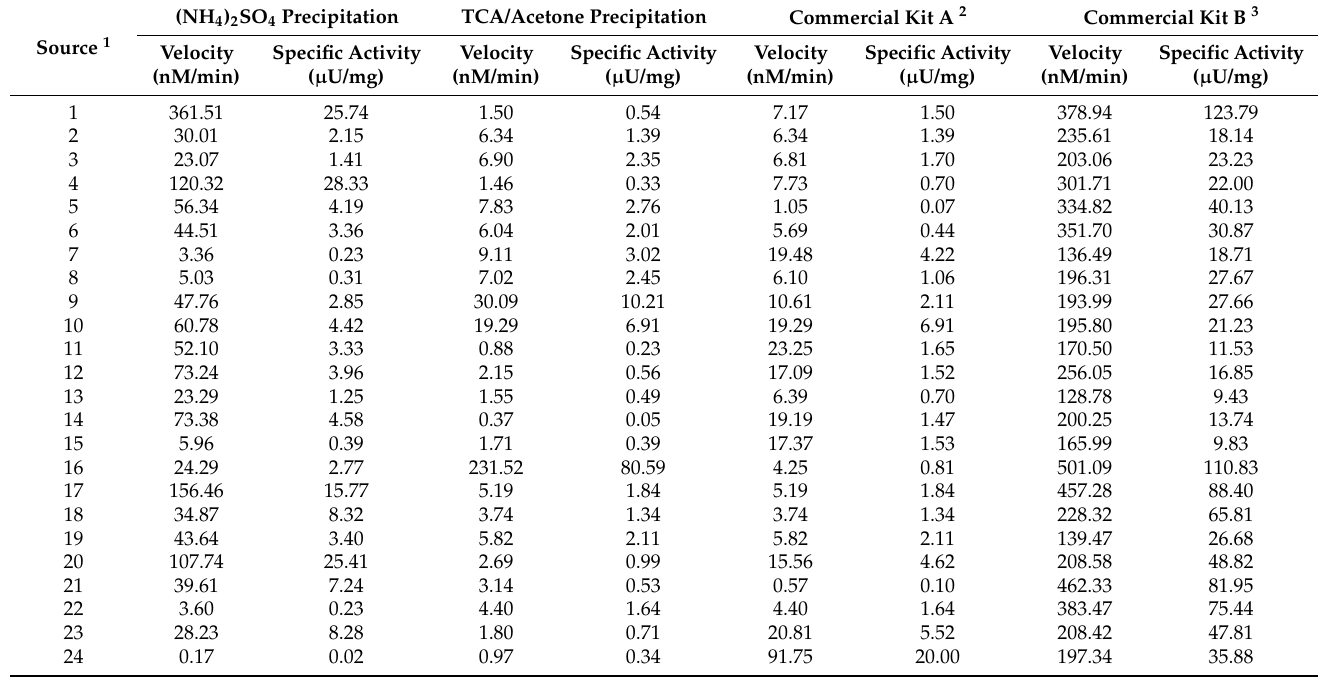
Table 3. Specific activity of crude protein extracts from 24 domestic agricultural products (fluorometric assay).